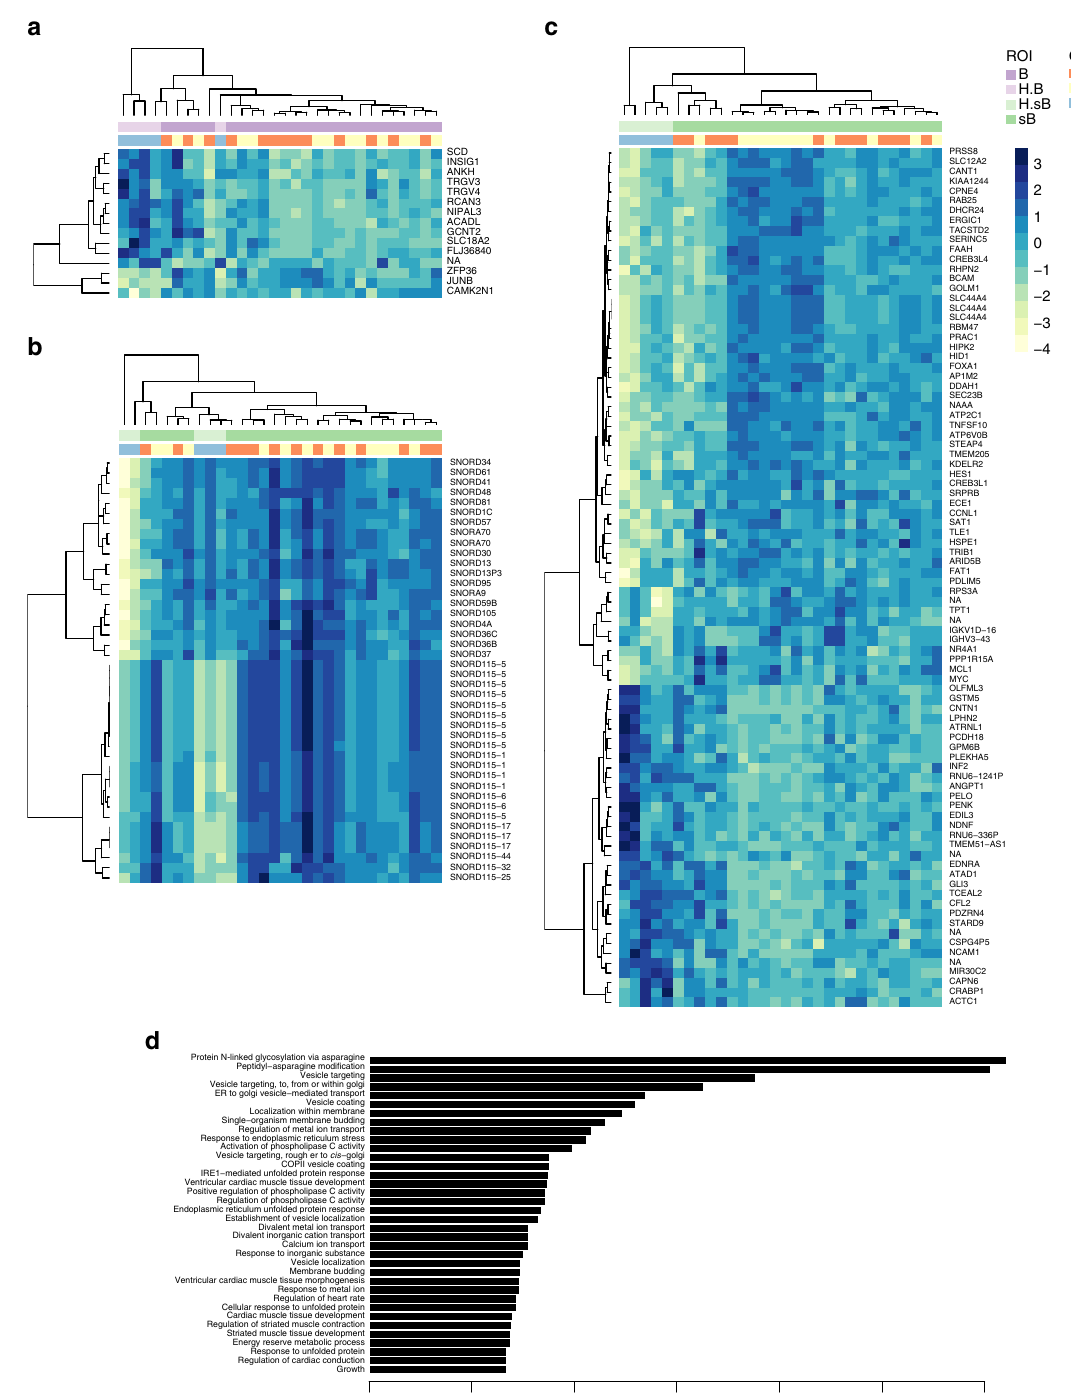
Fig. 3 Genes and pathways differentially expressed in benign tissue between cystoprostatectomy and RP specimens. a Heatmap of genes differentially expressed in benign epithelium of prostate cancer patients and cystoprostatectomy patients without prostate cancer. Gleason grade corresponds to the grade of the prostate tumor present in the block and NT (no tumor) denotes cystoprostatectomy cases. b Heatmap of genes and c heatmap of SNORDs differentially expressed in stroma surrounding benign glands from prostate cancer patients and cystoprostatectomy patients without prostate cancer. d – Log10 FDR-values from the pathways analysis of the genes differentially expressed in benign stroma using GO biological processes annotations tumor-associated stroma by a single number in order to study reached statistical signi fi cance when stroma surrounding benign behavior of this group of genes as a whole. When comparing the high and low-Gleason score cases, the difference in the score was cancers was compared (sB.high-sB.low), the difference in ssGSEA − 3 ). Interest- highly statistically signi fi cant (Fig. 4a; t -test, P ≤ 10 scores for this comparison was marginally signi fi cant (Fig. 4b; t - ingly, while none of the individual genes from the signature test, P = 0.08). NATURE COMMUNICATIONS | 8: